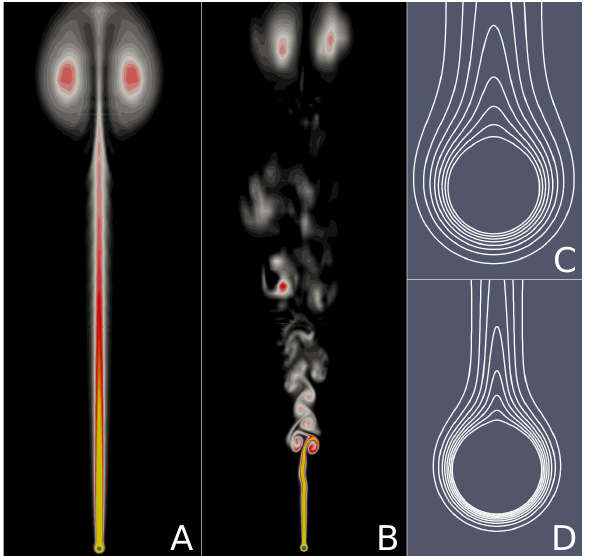
Fig. 8. Comparison of temperature fields for Ra = 10 3 , (A and C), and Ra = 10 4 , (B and D). 8 contours visible in the cylinder area (C, D) have regular spacing and cover range of temperature T ∈ (1 : 1 . 05).